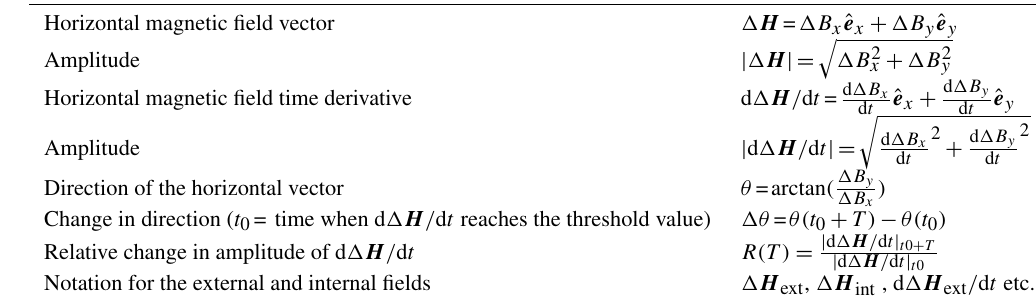
Table 1. Definitions for quantities used in this study. ˆ e x and ˆ e y are the northward and eastward unit vectors. Horizontal magnetic field vector